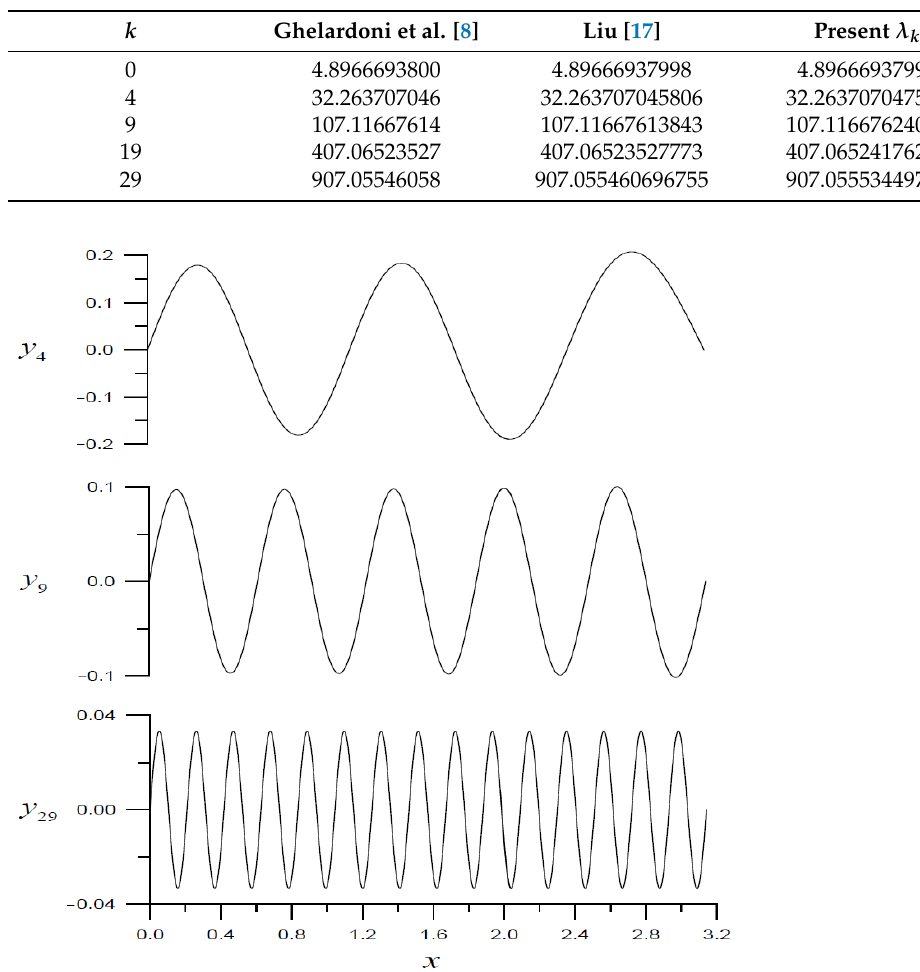
Table 2. Comparison of the eigenvalues for Example 2 with those in the previous literature.